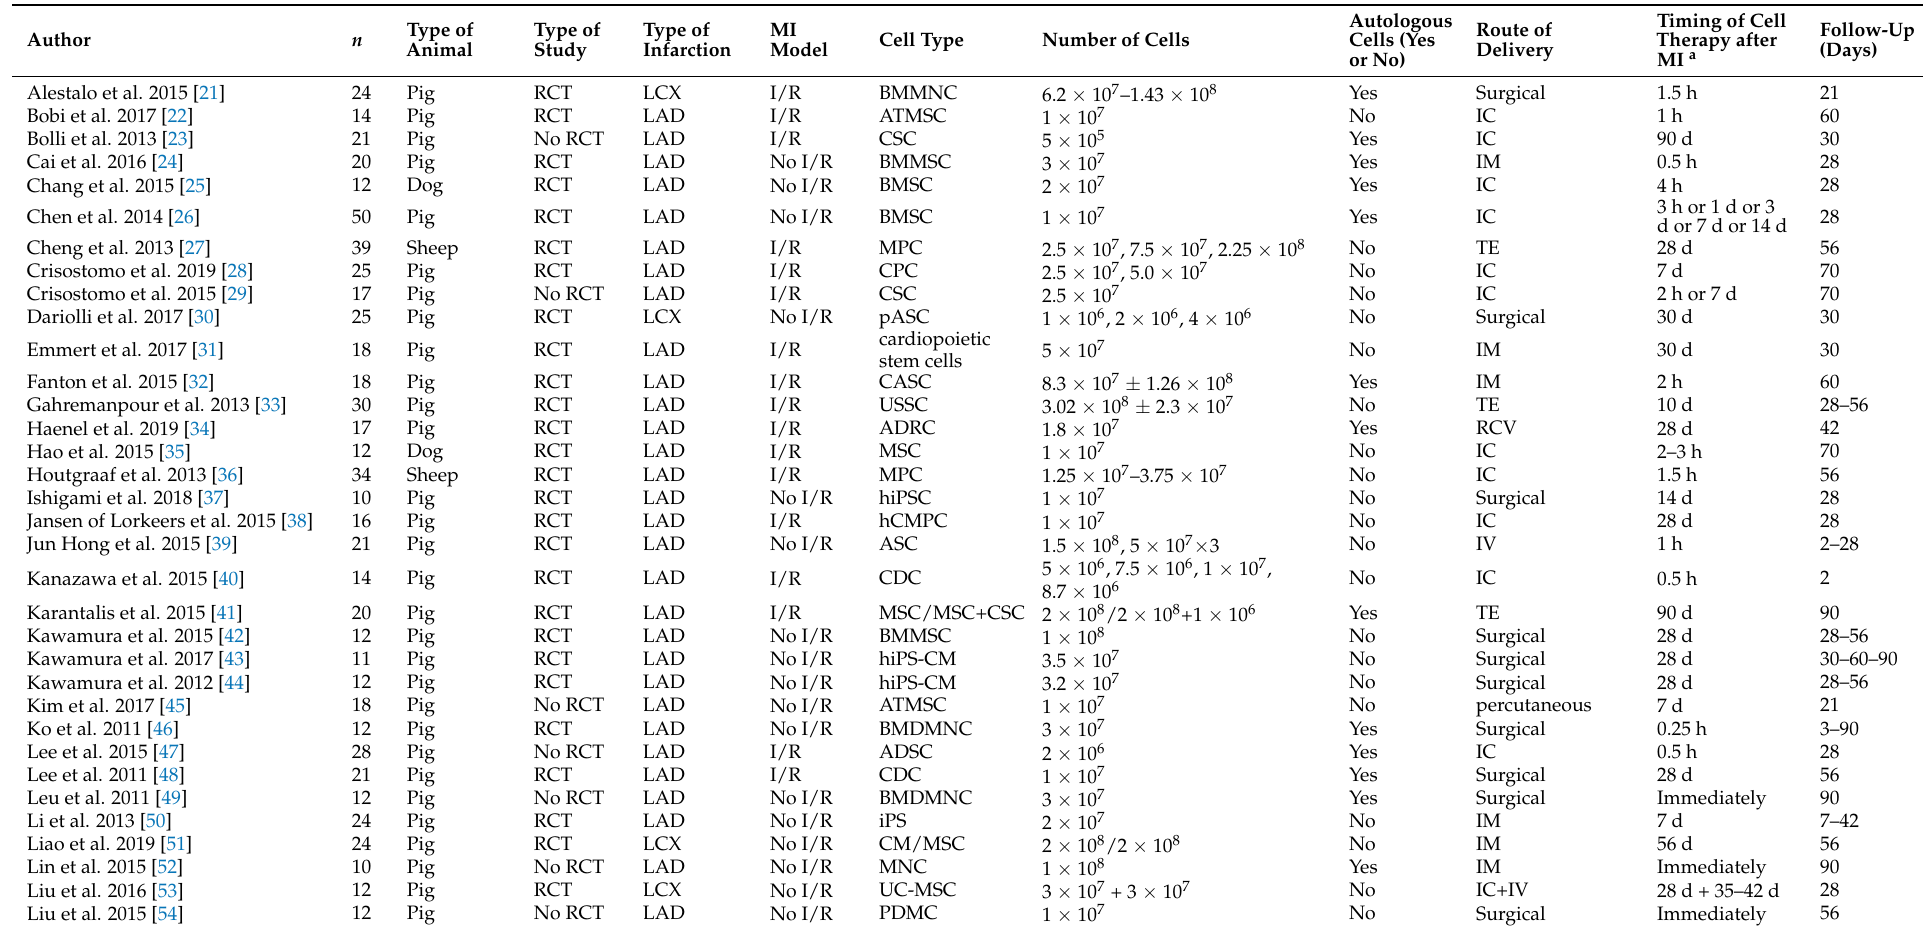
Table 1. Characteristics of the included